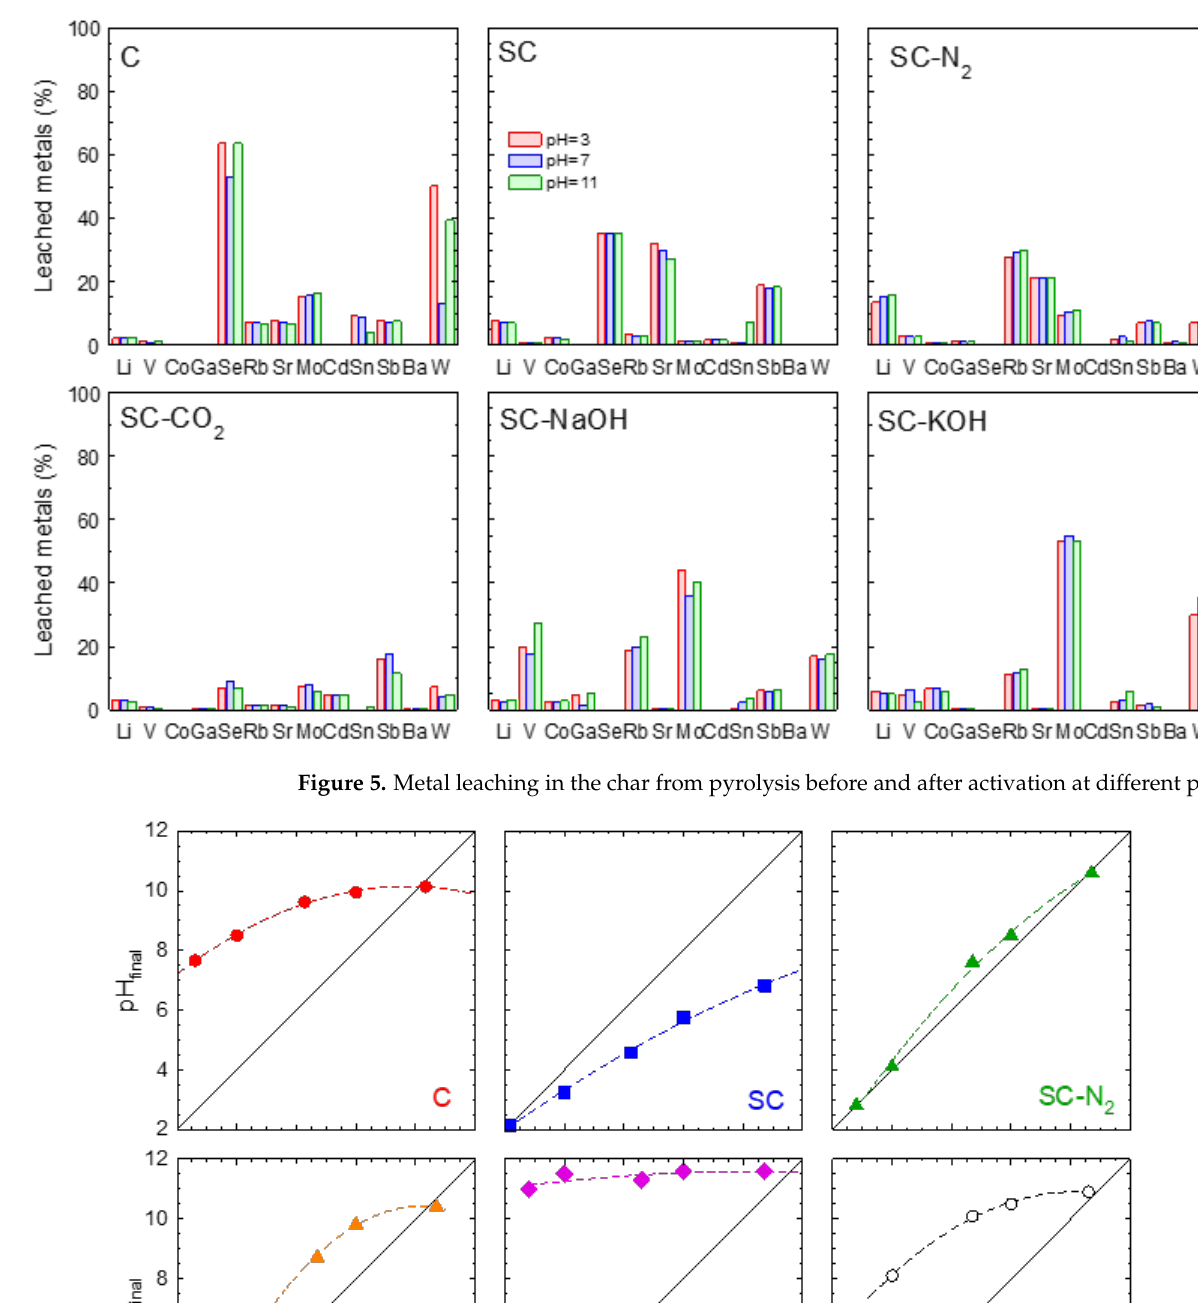
Figure 6. Determination of the pH pzc by the drift method of the char from plastic pyrolysis before and after activation. and after